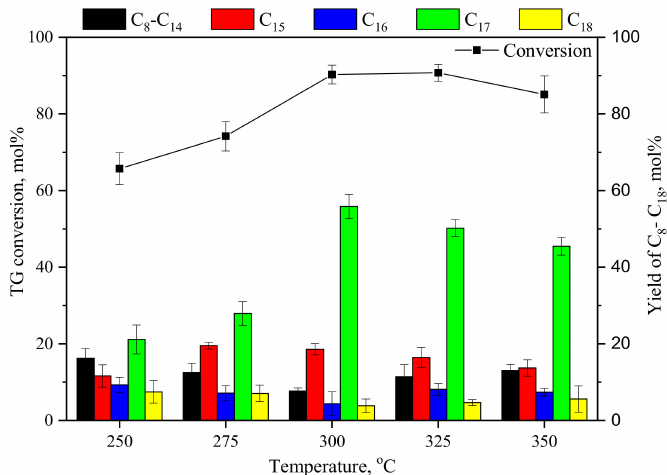
Figure 2. Conversion of triglycerides and yield of C 8 –C 18 products under di ff erent reaction